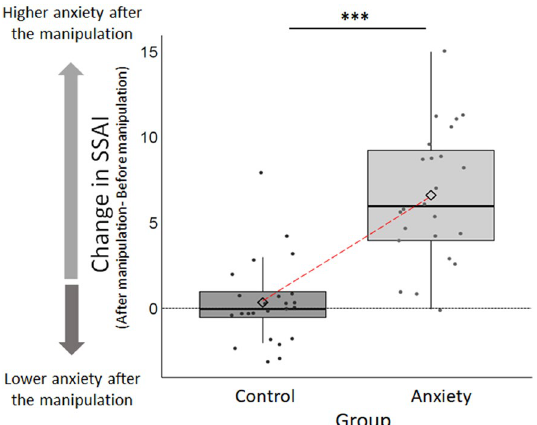
Figure 5. Change in anxiety levels was stronger in the induced anxiety group as compared to the control group (Study 2b). Plotted is the change in SSAI induced by the manipulation in both groups. Change in anxiety was computed for each individual by subtracting the SSAI score before the manipulation from the SSAI score after the manipulation. Horizontal lines indicate median values, boxes indicate 25–75% interquartile range, diamonds indicate mean values, the horizontal dotted line indicate 0 change in anxiety scores and whiskers indicate 1.5 × interquartile range; individual scores are shown separately as dots. ***p < 0.001.